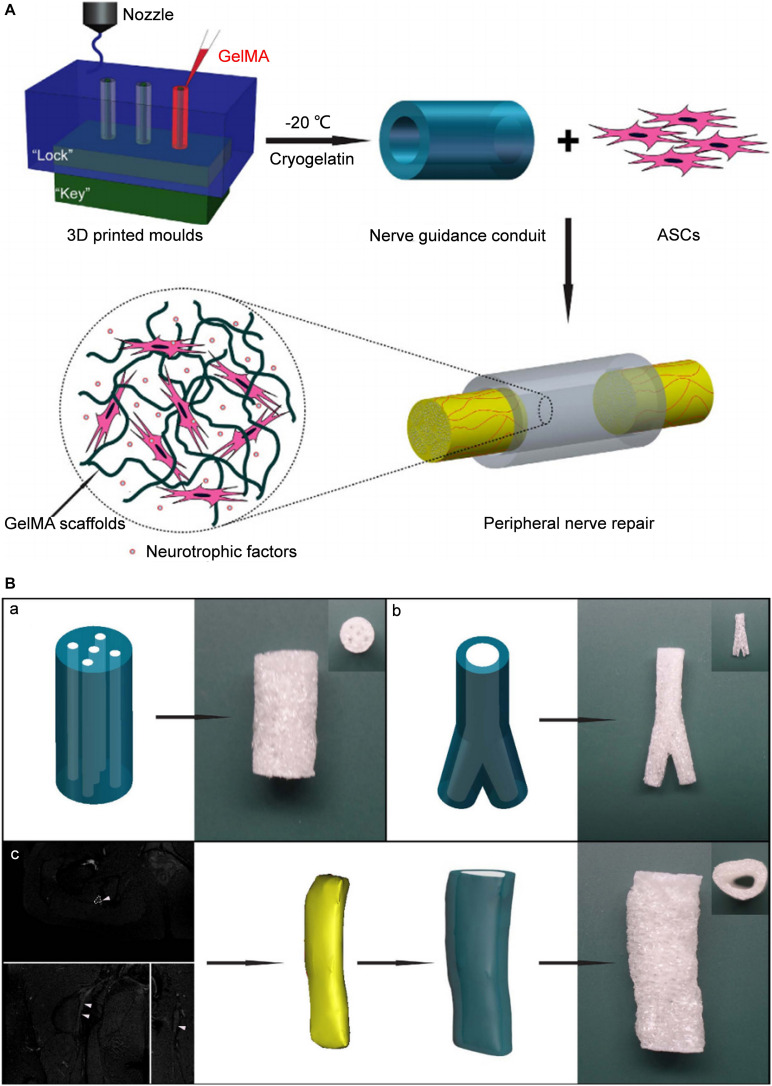
Schematic diagram of tissue engineered NGCs by indirect bioprinting, and computer models and photographs of complex structured NGCs. (A) Schematic diagram of tissue engineered nerve conduits. (B) Computer models and photographs of (a) 4-channel, (b) bifurcating. (c) MRI scan of the human sciatic nerve and the photograph of the corresponding nerve conduit. Reproduced with permission from Hu et al. (2016).